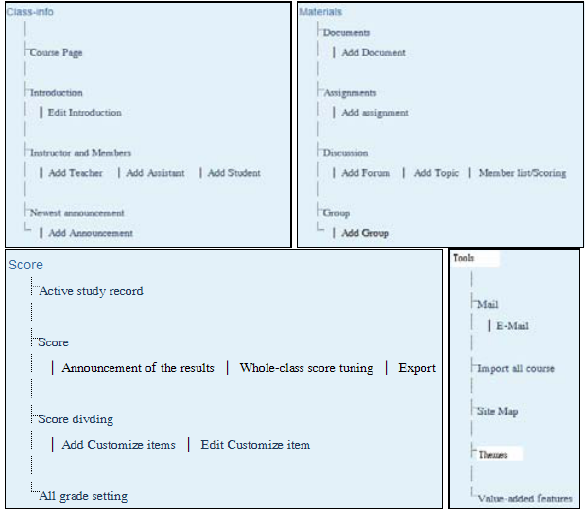
Figure 3. Site map of course.